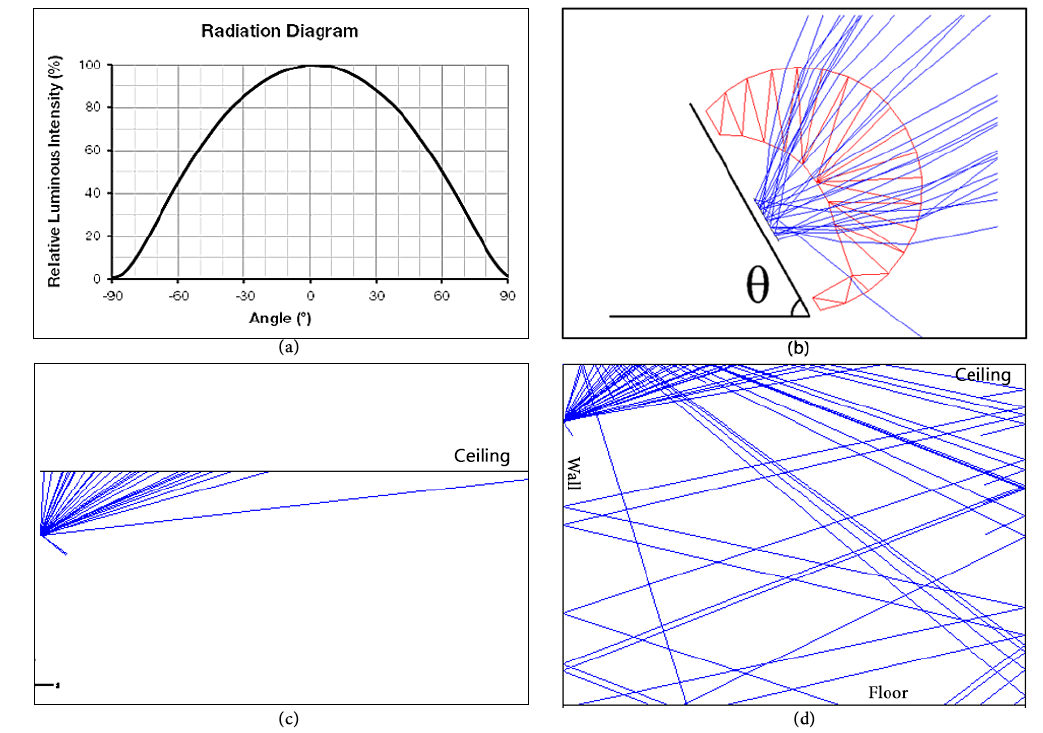
Figure 2. ( a ) Beam angle characteristics of the LED; ( b ) A close look of the setup of the simulation. θ is the relative angle between the LED and the lens to horizontal axis ( c ) Setup of the simulation of the luminaire to the ceiling with θ = 50 ◦ and distance d = 40 cm ( d ) Setup of the simulation of the luminaire to the ceiling and to two reflection surfaces. Sizes of the surfaces imitates the size of a real room: 4 m long, 4 m wide and 3 m